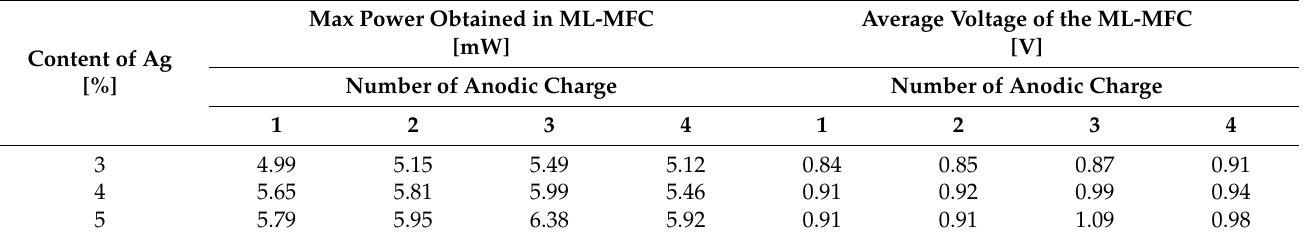
Table 3. Power and voltage (maximum value) obtained in ML-MFC (powered with PYWW). Cathode: Cu-Ag (foam form) oxidized for 6 h, and after an anodic charge (after 1, 2, 3, 4 times of charging). Max Power Obtained in Content of Ag